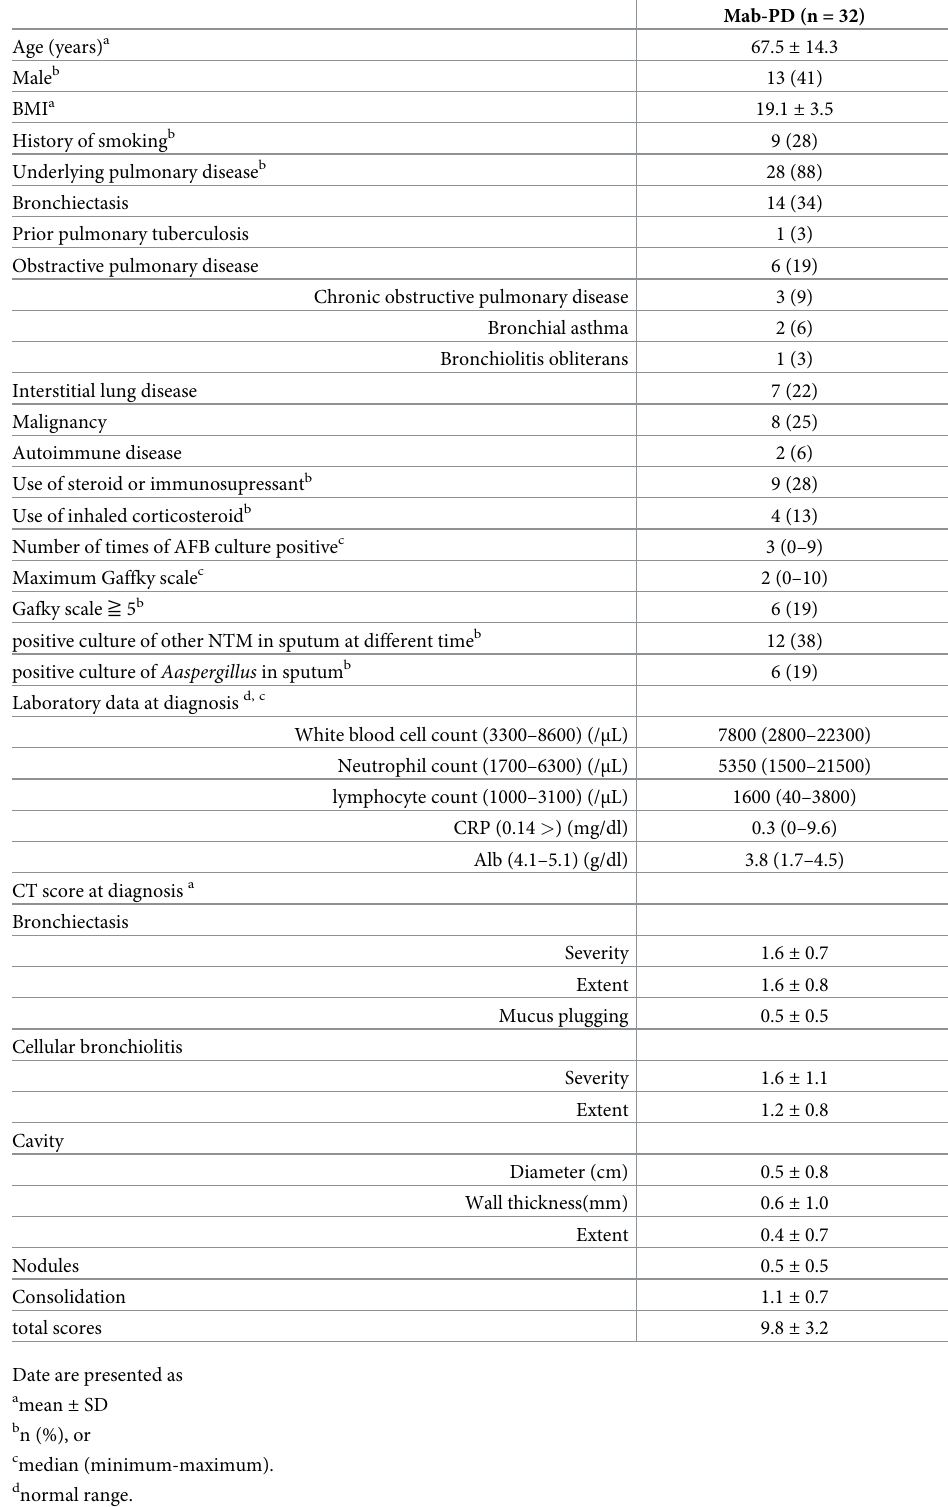
Table 1. Characteristics of patients and CT scores at